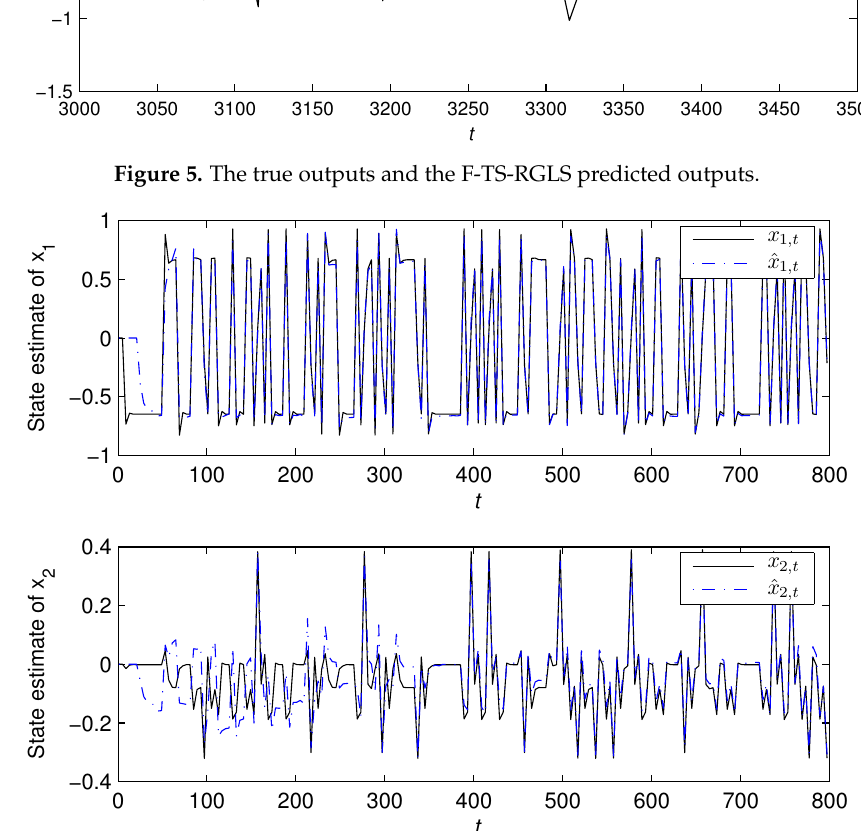
Figure 6. State x t and its estimate ˆ x t versus t ( σ 2 = 0.10 2